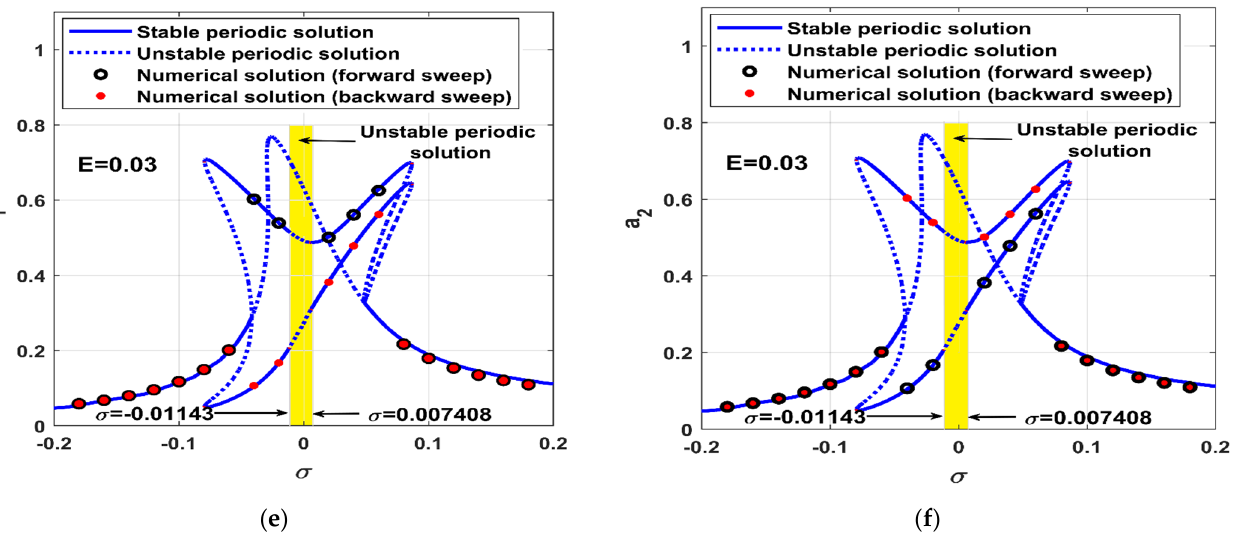
Figure 6. 𝜎 − response curve of the controlled Jeffcott rotor (i.e., 𝛿 (cid:2869) = 0.83 , and 𝛿 (cid:2870) = 0.002 ) at three different values of the shaft eccentricity 𝐸 : ( a , b ) oscillation amplitudes ( 𝑎 (cid:2869) and 𝑎 (cid:2870) ) versus 𝜎 when 𝐸 = 0.01 , ( c , d ) oscillation amplitudes ( 𝑎 (cid:2869) and 𝑎 (cid:2870) ) versus 𝜎 when 𝐸 = 0.02 , and ( e , f ) oscillation amplitudes ( 𝑎 (cid:2869) and 𝑎 (cid:2870) ) versus 𝜎 when 𝐸 = 0.03 .